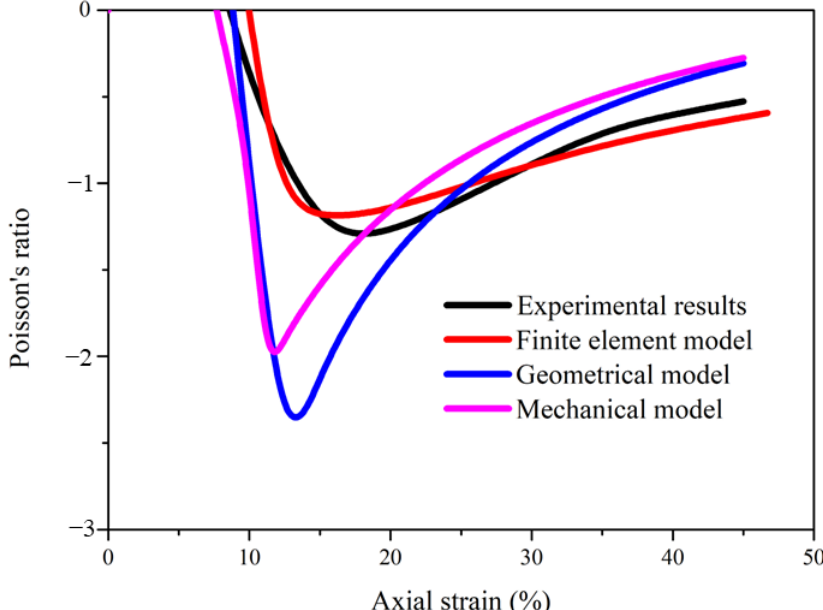
Figure 3. Comparison of Poisson’s ratio between experimental results and theoretical results.